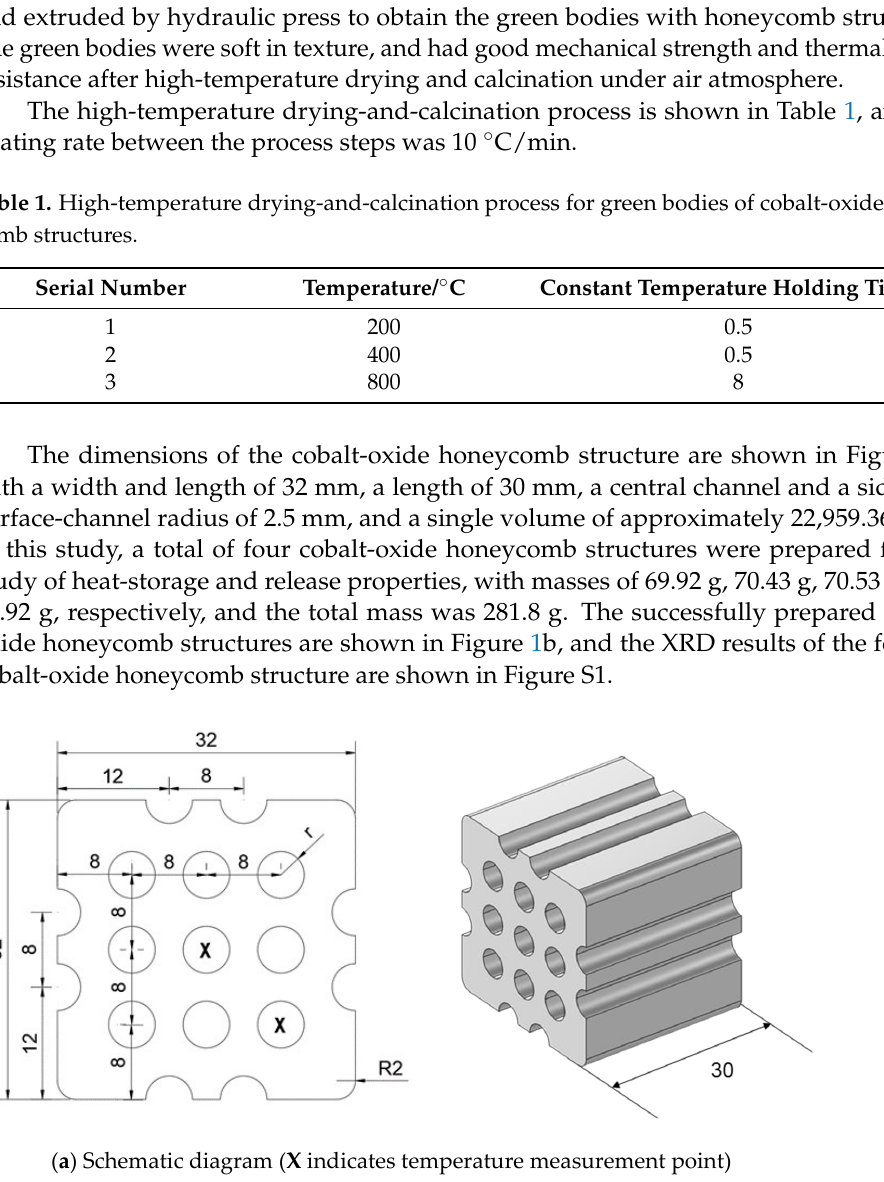
( b ) Physical drawing Figure 1. Cobalt-oxide honeycomb structure. 2.2. Honeycomb-Structure-Body Charging/Discharging Test Platform The cobalt oxide (Co 3 O 4 /CoO) system completes the charging (heat storage) and dis- charging (heat release) processes through redox reactions. In the high-temperature state, the charging step is completed by the reduction reaction based on cobalt oxide, and, sim- ilarly, the discharging step is completed by the oxidation reaction at a low temperature (compared to the reduction reaction temperature). The basic reactions of the charging and discharging processes can be expressed as [15]: Co (cid:2871) O (cid:2872) ↔ 3CoO + 1 2⁄ O (cid:2870)